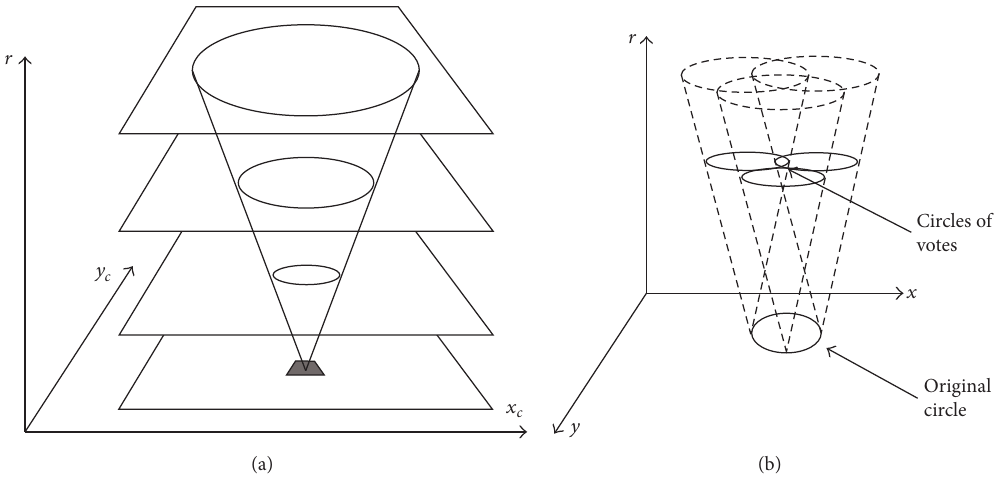
Figure 4: (a) 3D accumulator array in planner form. (b) 3D accumulator array in multiconical